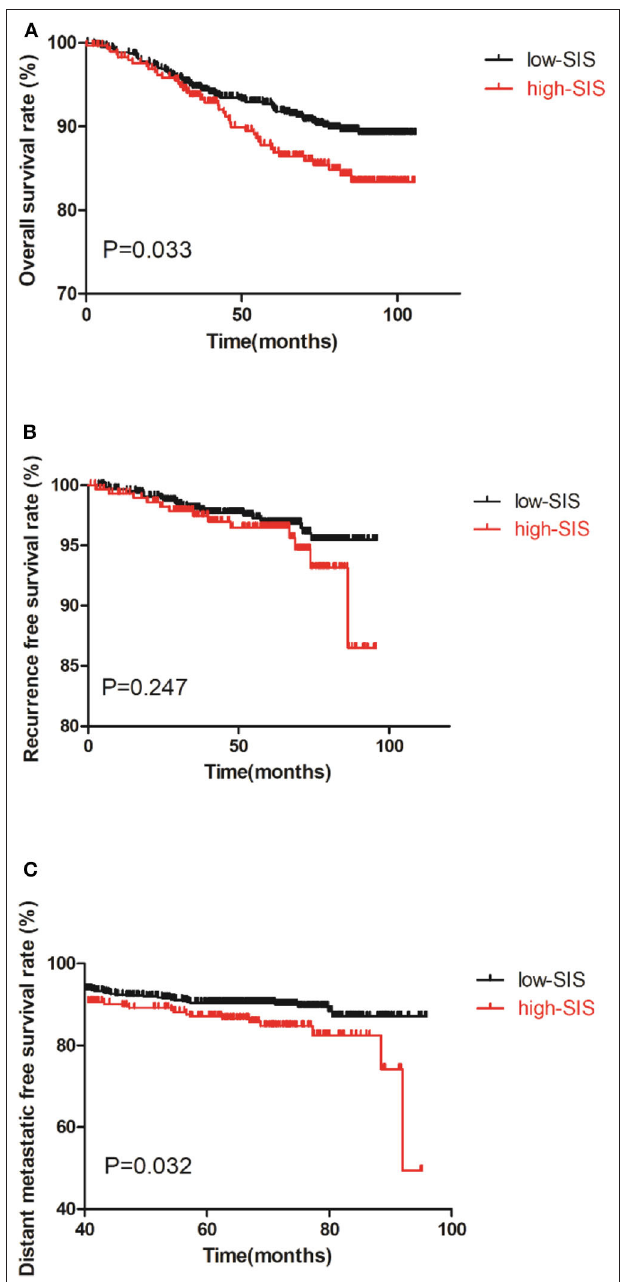
FIGURE 1 | Kaplan-Meier survival curves of the training set of patients with breast cancer patients after surgery. (A) is the survival curves for OS, (B) is the survival curves for RFS, (C) is the survival curves for